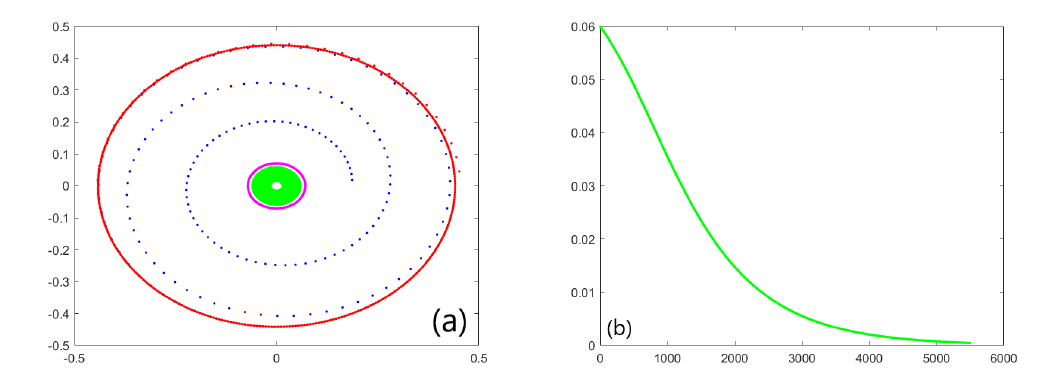
2 + 2 α 3 − α − α 2 α 2 , 1 α 2 2 1 1